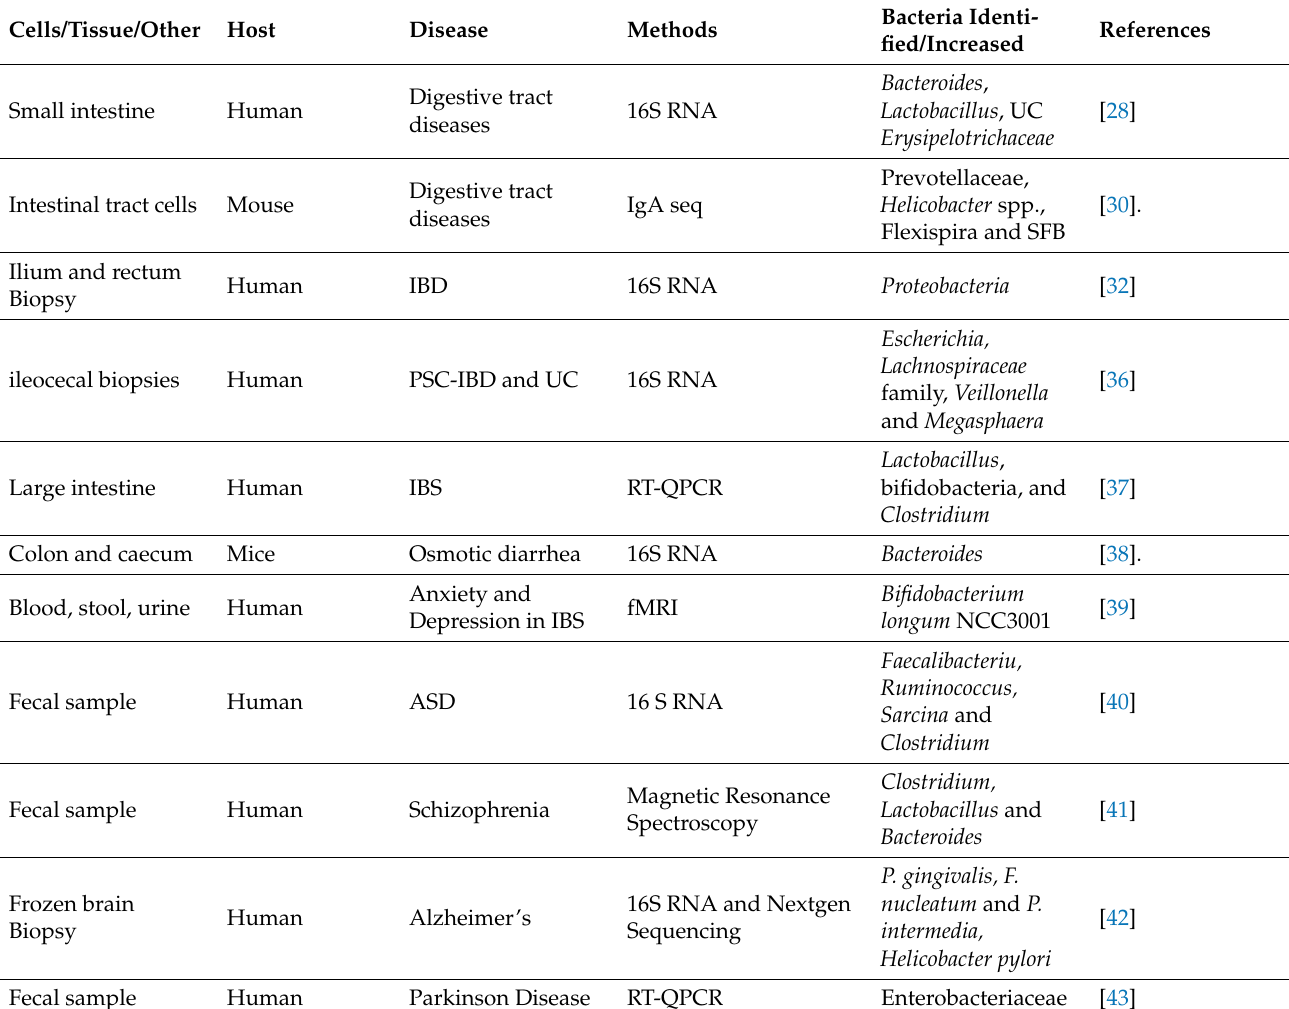
Table 1. Microbiota associated in diseases. The abundance of bacteria identified in various diseases.